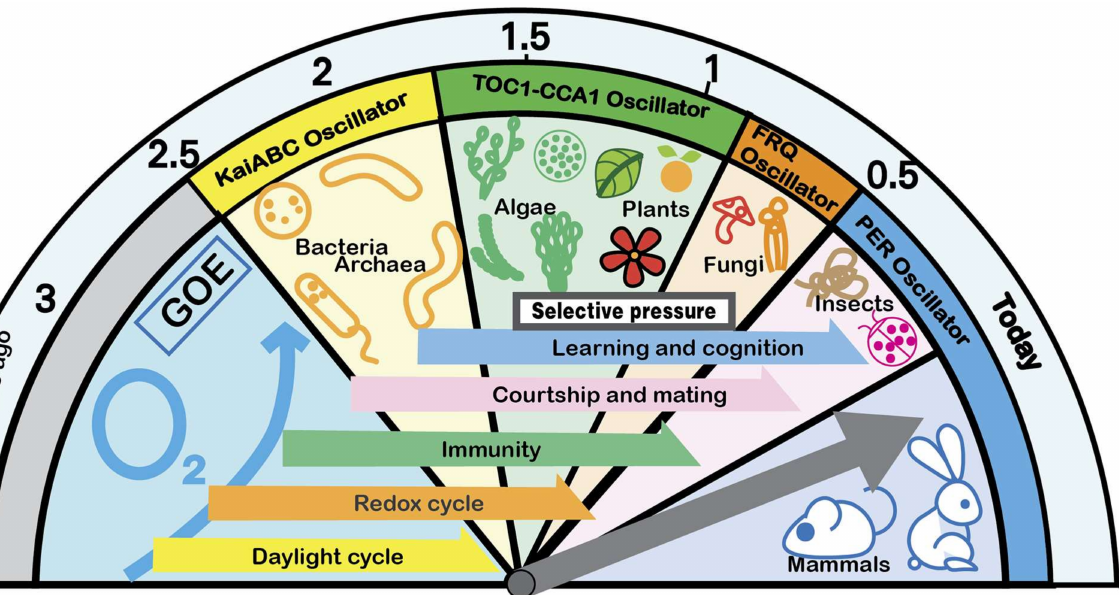
Figure 1. Selective pressure drives the evolution of the biological clock. The biological clocks of various organisms are derived from the selection pressure given by the natural environment. Various selection pressures are the main driving force that drives the biological clock to become more complex and refined. Since the Great Oxygenation Event (GOE) began 3 billion years ago, the biological clock has become more and more complex and manifests in different forms on different species. From the post-translational oscillation (PTO) mechanism to the transcription–translation negative feedback (TTFL) mechanism, the overall biological clock system of life reflects the trend of step